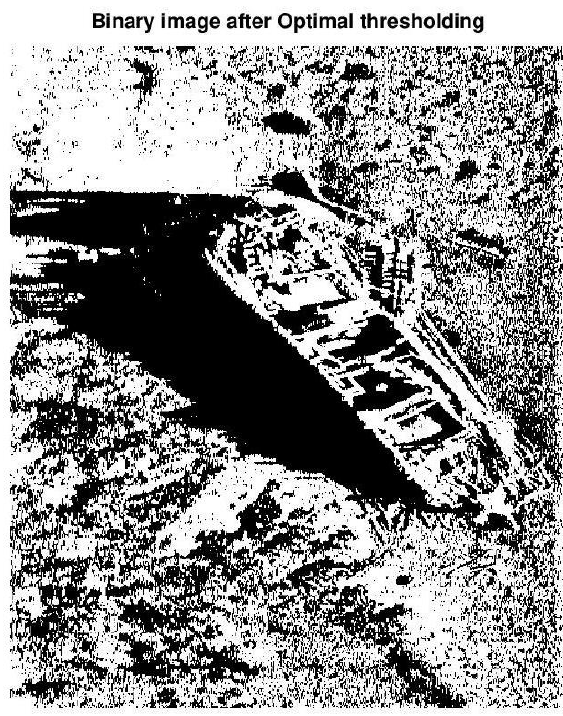
Figure 4. Binary image after optimal thresholding.